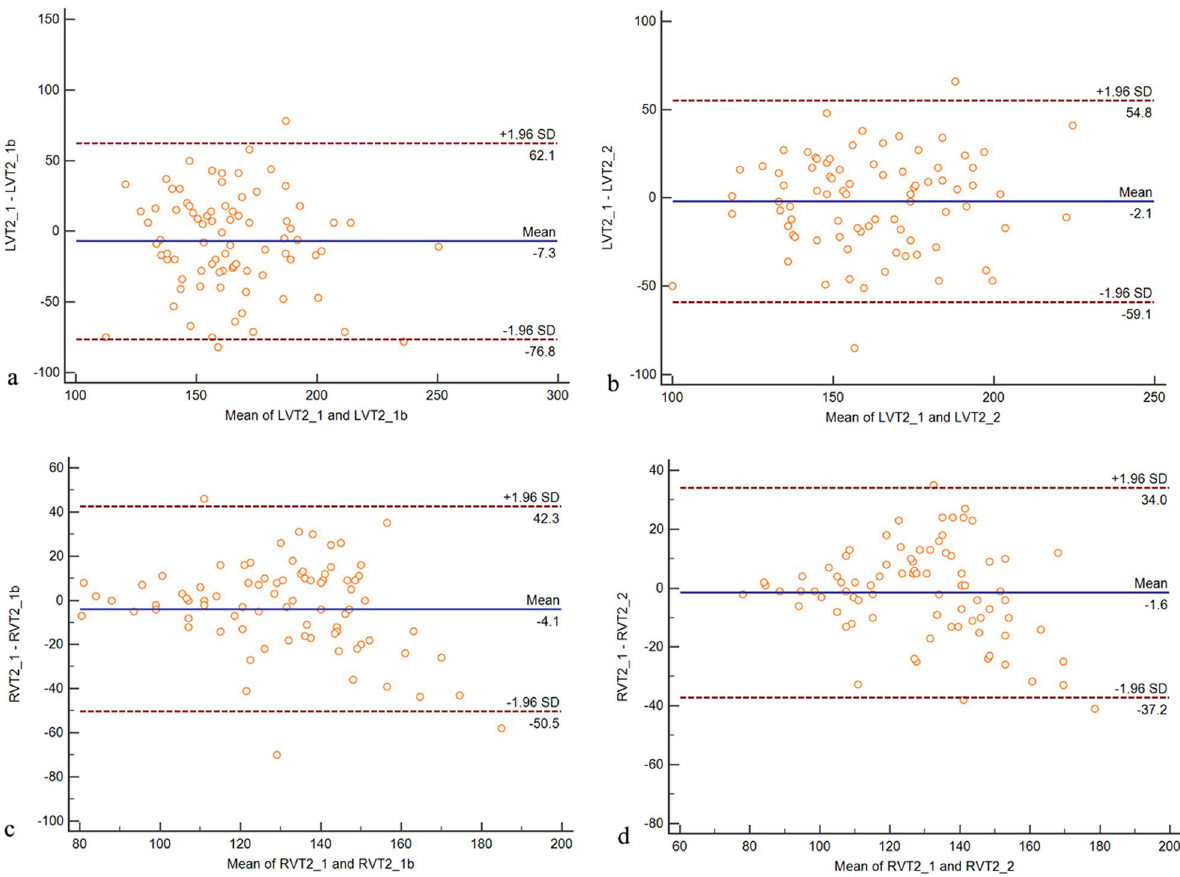
Fig. 3 A Bland–Altman plot of left ventricular blood pool T2 (LVT2) and right ventricular blood pool T2 (RVT2)measurements. a The intra-observer mean difference for LVT2 was intra-observer mean difference for RVT2 was